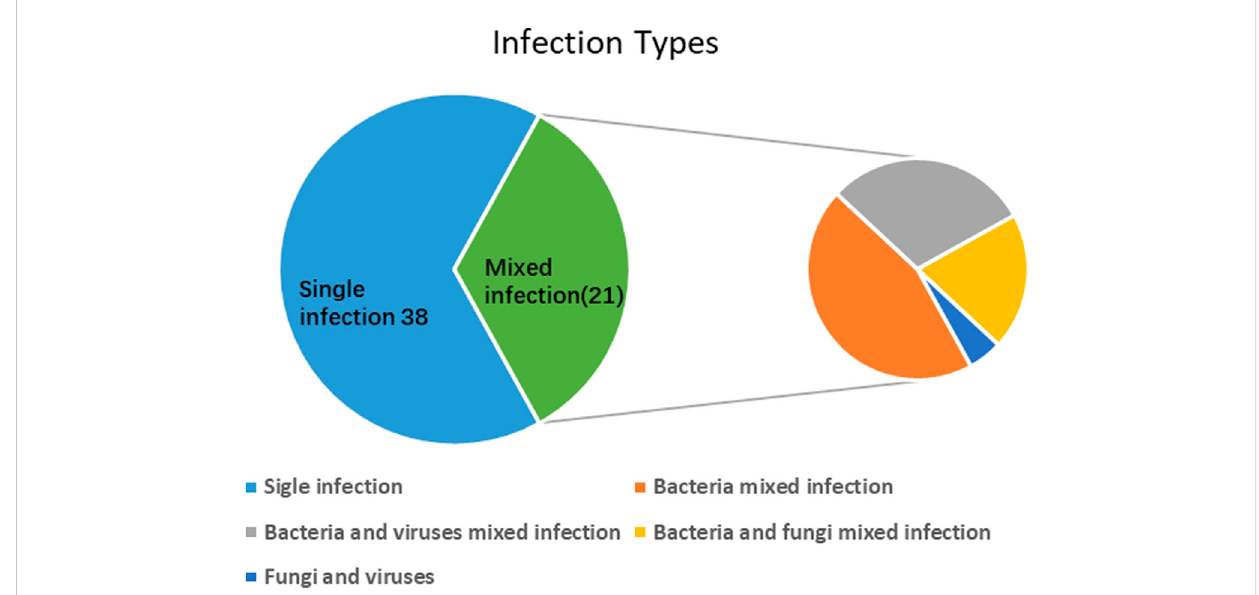
FIGURE 4 Mixed infections detected by mNGS and conventional tests.